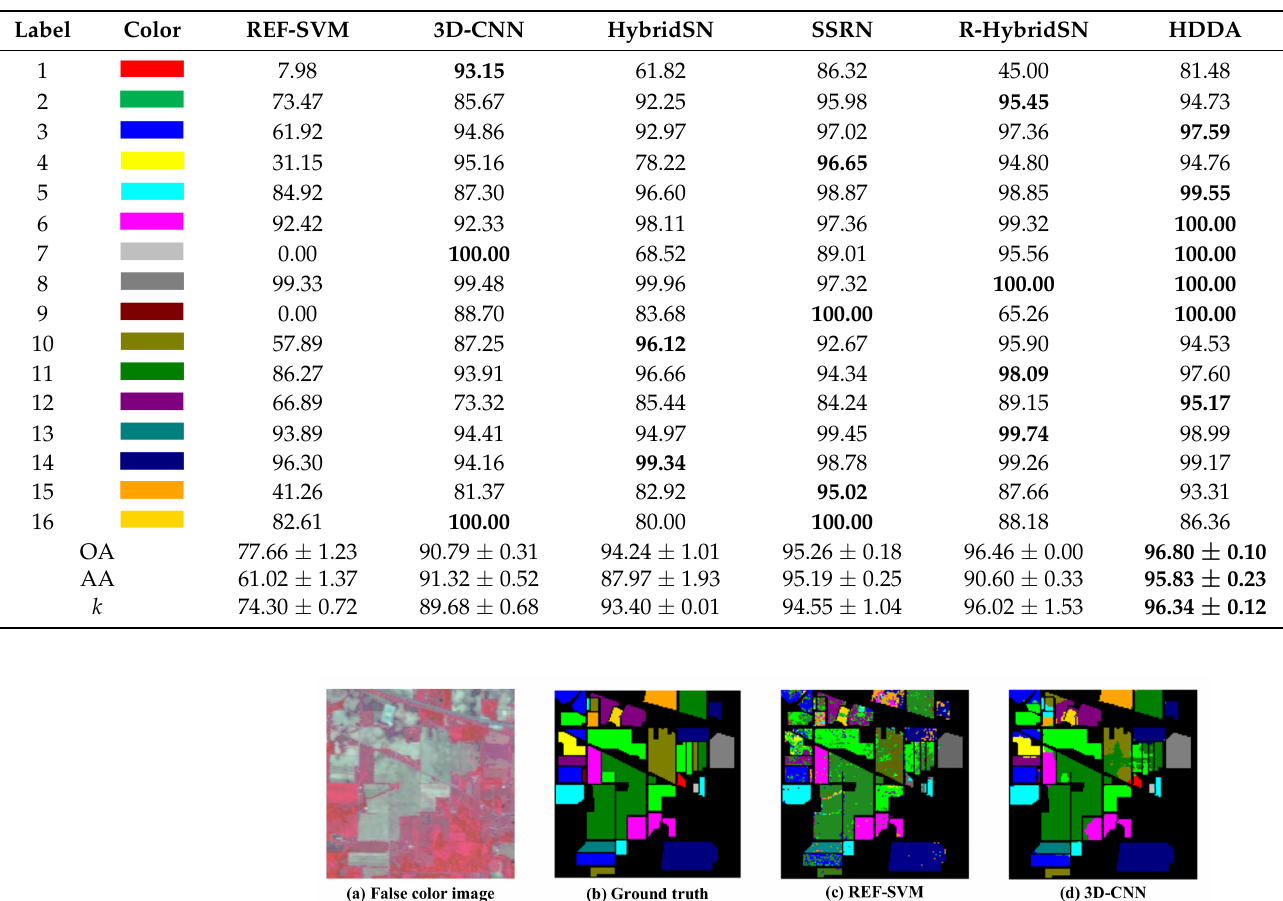
Table 8. Comparison of accuracy using the HDDA and five other methods for the IP dataset.